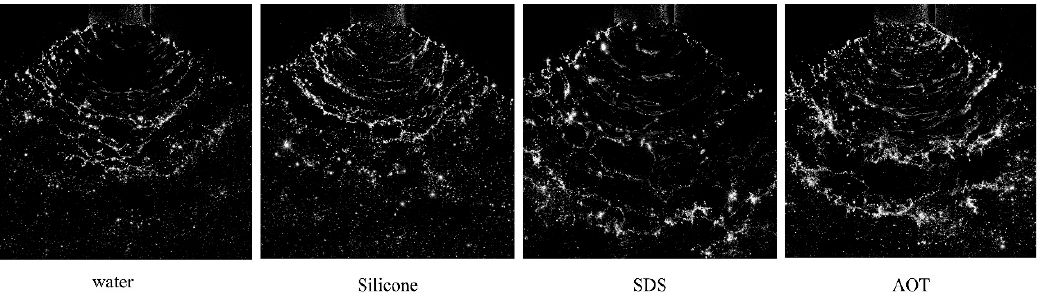
Figure 4. Spray images of XR nozzle with water, silicone, SDS, and AOT.